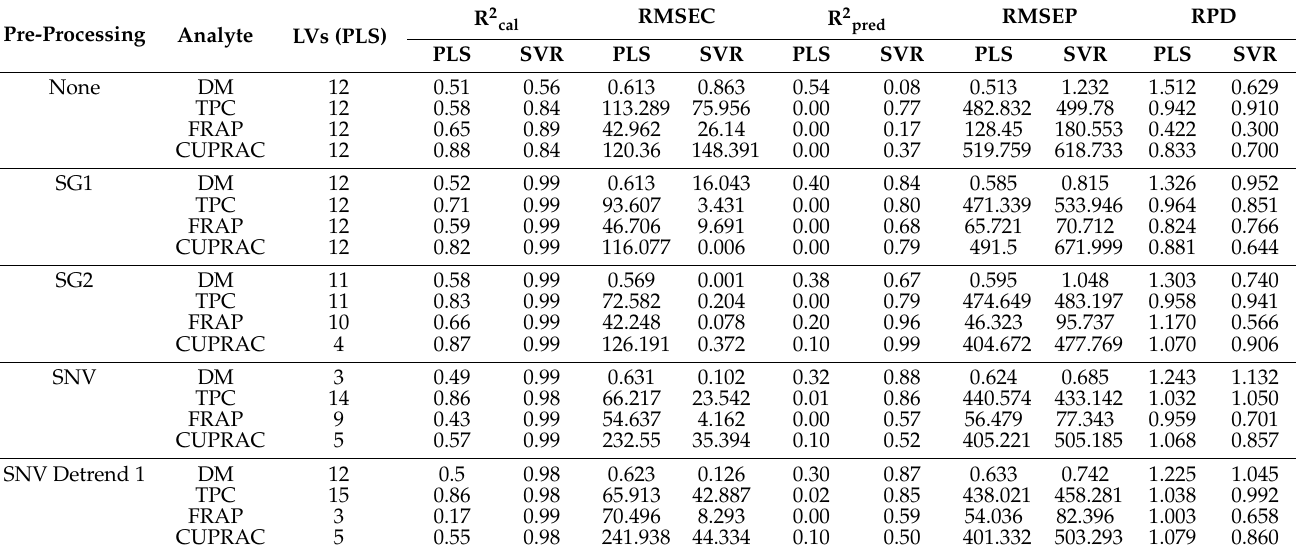
Figure 4. Predicted vs. reference results for the application of MIR spectroscopy for the prediction of dry matter, TPC, FRAP, and CUPRAC contents. Table 4. Statistical parameters were obtained from the application of the PLSR and SVR algorithms on the MIR spectra dataset using different pre-processing